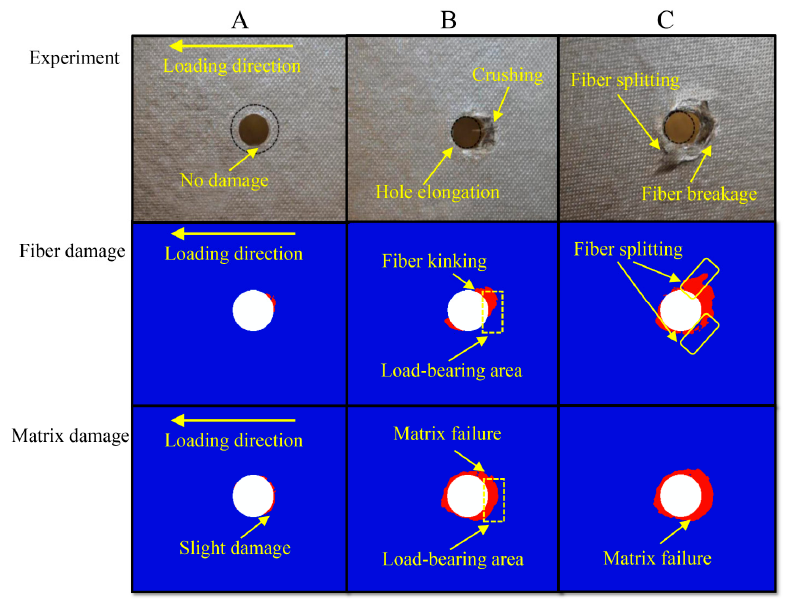
Figure 6. Experimental results [13] and numerical calculation of damage states around holes at states A, B, and C on the lower